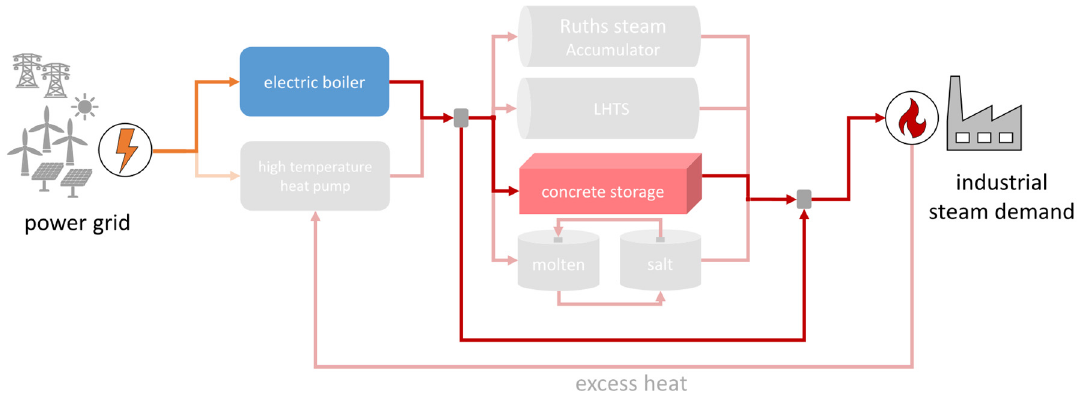
Figure 10. Optimal power-to-heat (P2H) system for Case 1.